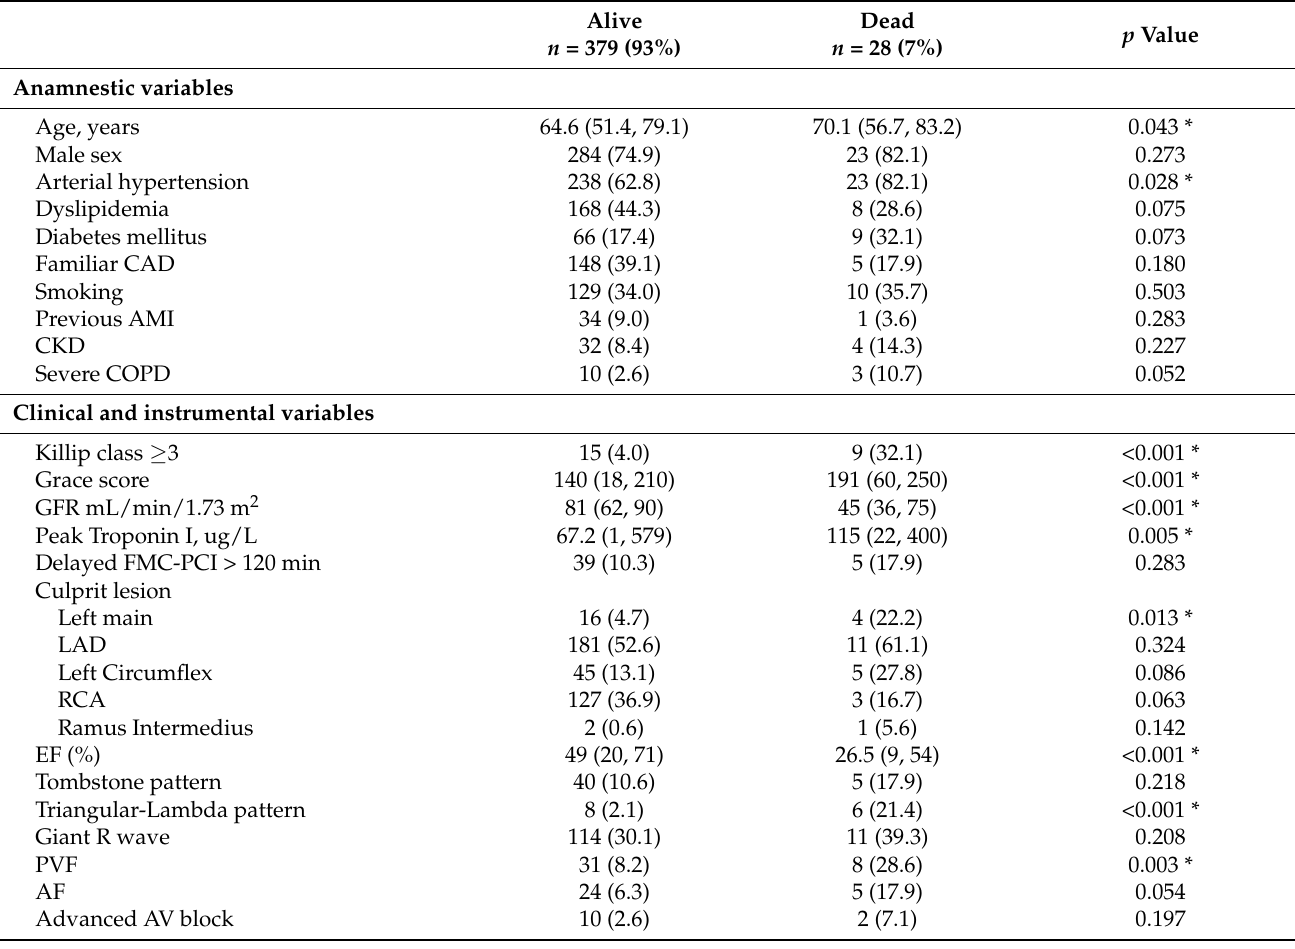
Table 4. Distribution of anamnestic, clinical, and instrumental variables among the groups with and without death at 30 days. * means p < 0.050. Values are expressed as number of patients (%) or median [25 and 75%